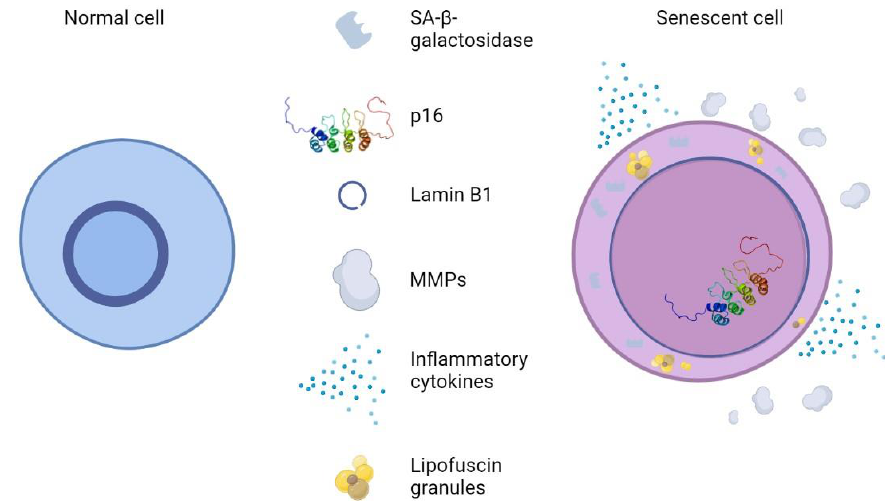
Figure 7. Normal skin cells vs. Senescent skin cells. Senescent cells are distinguished by changes in morphology, such as flattening and increased cell size, pronounced SA- β -galactosidase activity, p16 upregulation, reduction in nuclear lamin B1, and SASP-like MMPs and inflammatory cytokines.